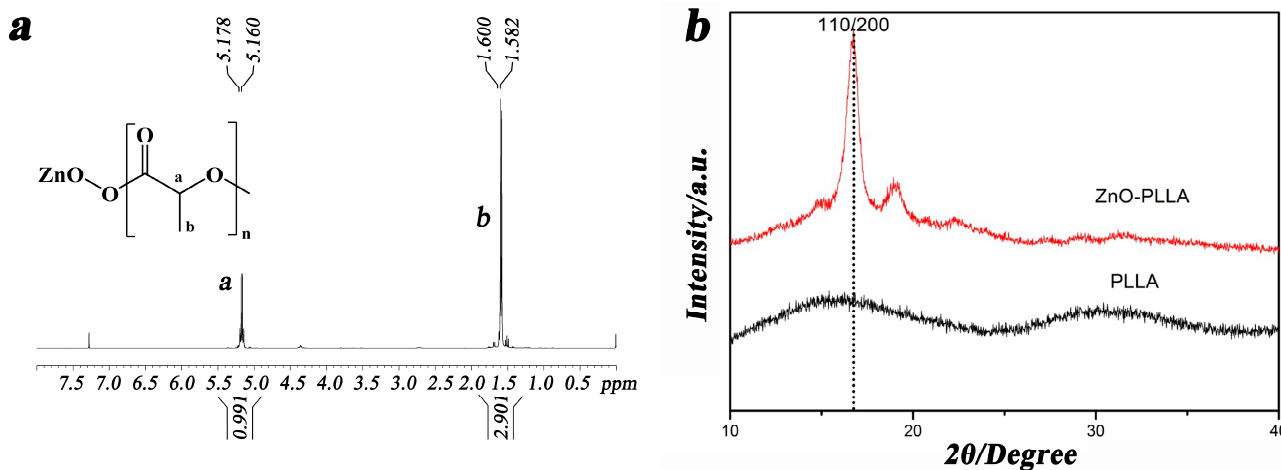
Figure 2. The result of ( a ) H-NMR; ( b ) XPS.